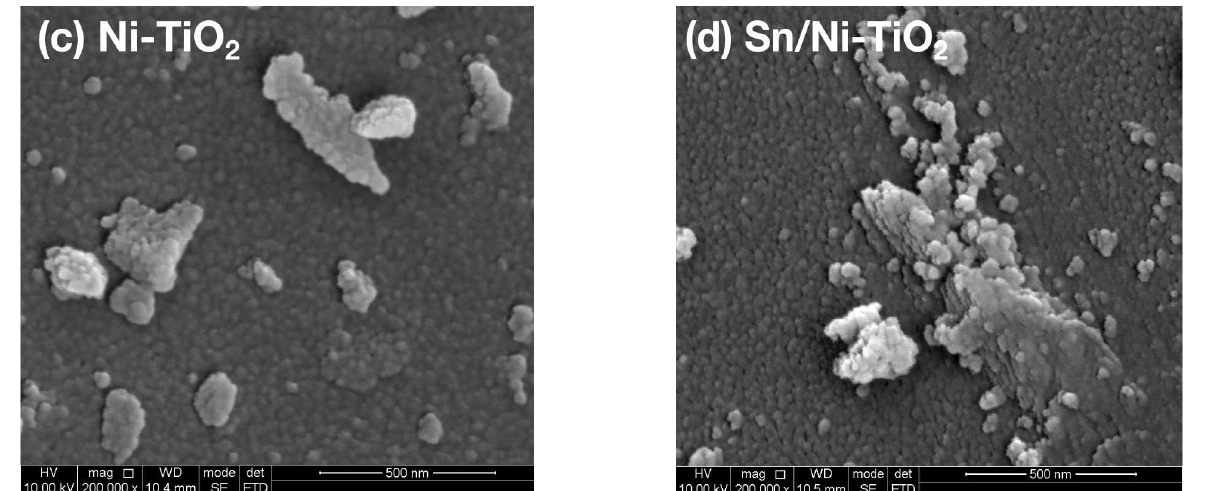
Figure 2. SEM images of samples: ( a ) pure TiO 2, ( b ) Sn–TiO 2 , ( c ) Ni–TiO 2 , ( d ) Sn/Ni–TiO 2. The TEM and HRTEM images of pure TiO 2 (a, c) and Sn–TiO 2 (b, d) were exhibited in Figure 3. It is observed that the single particle size of pure TiO 2 is 20–30 nm, and the particle size of Sn–TiO 2 is smaller (15–20 nm). The crystal plane spacing marked in Figure 3c 0.348 nm can be attributed to the anatase (101) crystal plane. In Figure 3d, the marked crystal plane spacing is 0.355 nm, ascribing to the crystal plane of anatase (101), which is slightly increased compared to pure TiO 2 [20]. As the radius of Sn 4+ is larger than Ti 4+ , Sn 4+ ions enter into TiO 2 lattice to replace Ti 4+ ions, causing lattice expansion and increasing the crystal plane spacing [35,36,37]. The interplanar spacing 0.325 nm in Figure 3d can be ascribed to the rutile (110) crystal plane, indicating that Sn–TiO 2 is mixed crystal structure [38]. This is consistent with XRD results.